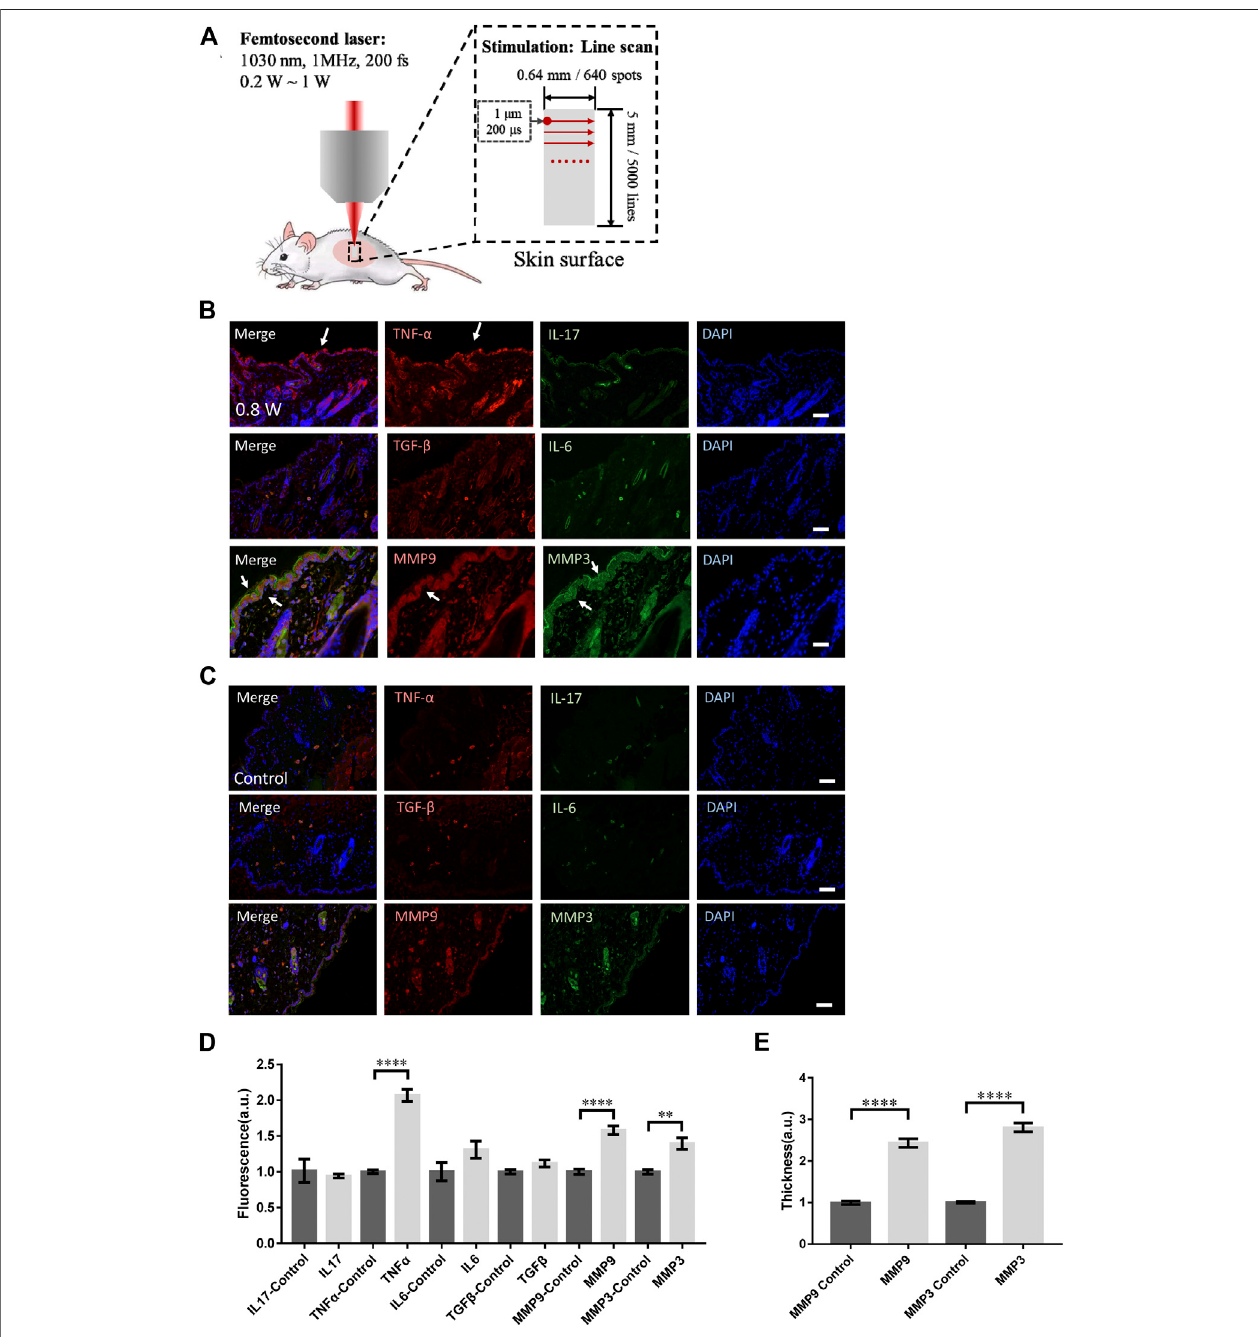
FIGURE1| Skinresponsestomicromachiningbyfemtosecondlaser. (A) Theschemeofmicromachiningbyfemtosecondlaseronskinofmouse.Thescanningoffemtosecond laser was controlled by a pair of galvo-mirror. The molecular responses to femtosecond laser micromachining of the skin tissue at 0.8 W (B) and control (C) . Arrows: the immuno fl uorescenceofthemolecules.Bar:100 μ m. (D) Statisticresultsofthe fl uorescenceintensityintheexperimentalandcontrolgroups(n (cid:1) 24samplesfromsixindependenttrails). (E) TheskinthicknesswithpositiveMMP3andMMP9signals(n (cid:1) 24samplesfromsixindependenttrails).* p < 0.05.** p < 0.01.*** p < 0.001.**** p < 0.0001,by students ’ t-test .